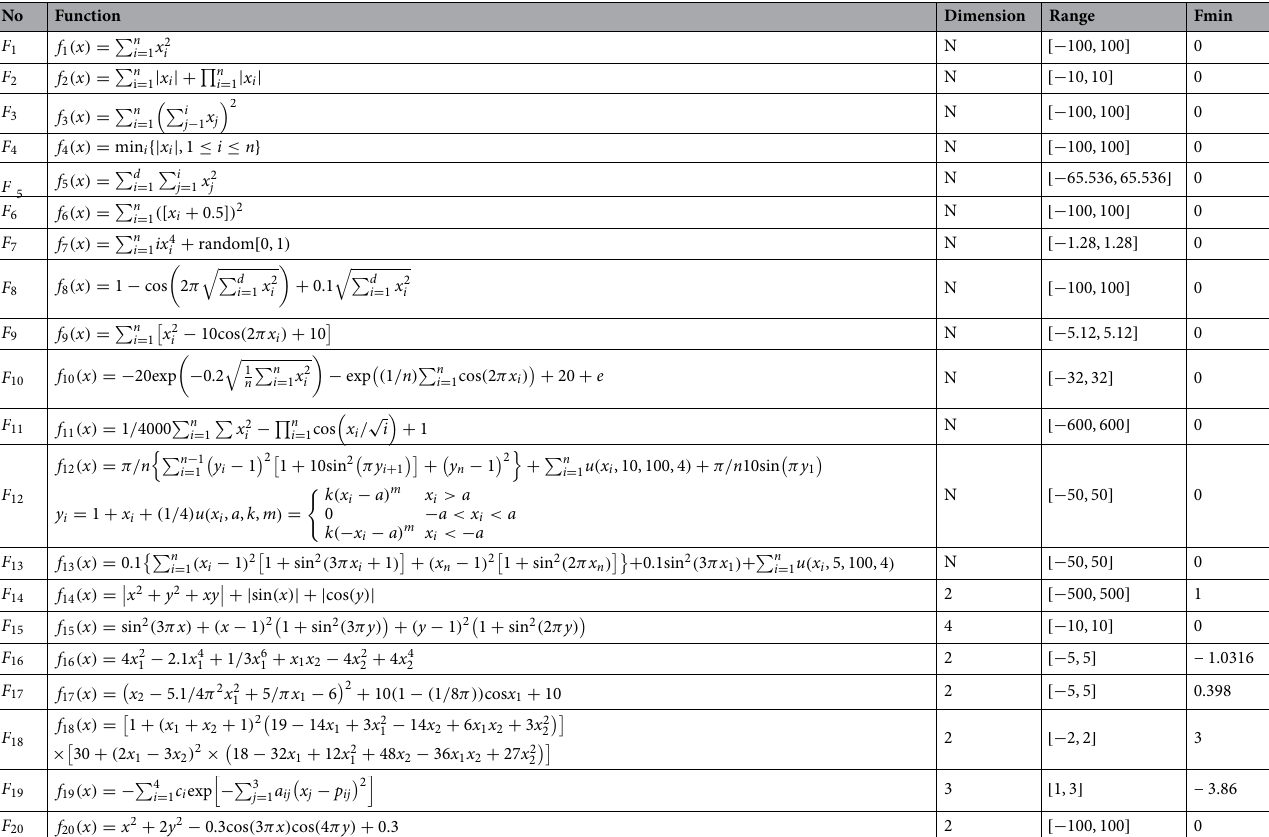
Table 1. Benchmark